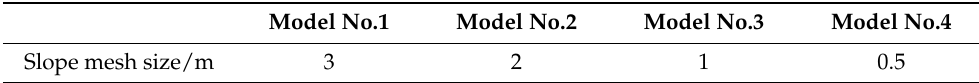
Table 5. Different slope mesh size